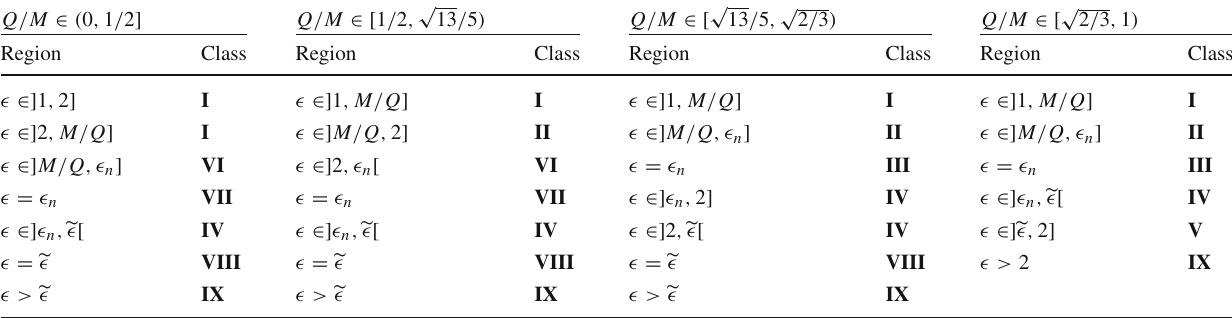
Table 3 Classification of the circular orbits of a charged test particle with charge-to-mass ratio (cid:2) > 1 in terms of the value of the ratio Q / M of a RN black